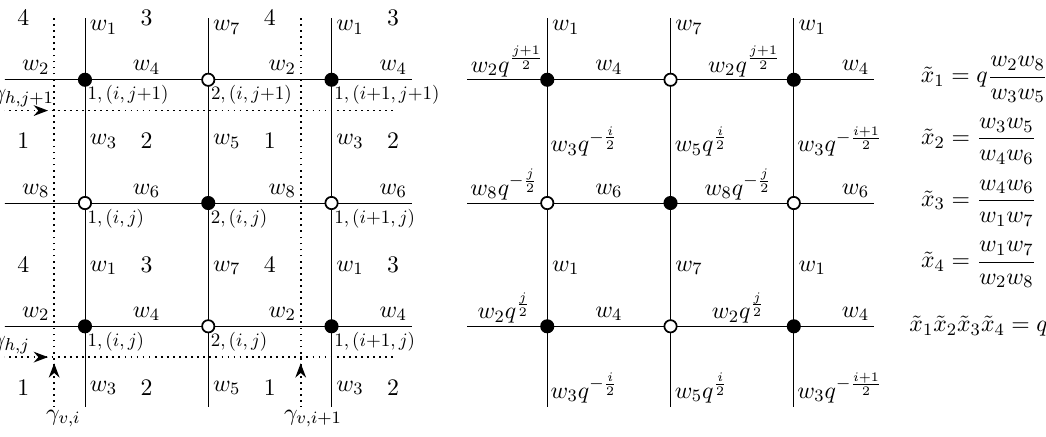
Figure 2 . Example of bipartite graph, known to describe Toda integrable chain on two sites. Left: labelling of vertices, faces, and edge weights. Since we consider only periodic weightings of faces, we do not put labels of their fundamental domains on the plot. Right: edges weighting of finite flux q = e − ε , according to (2.17) and face weights expressed in terms of edge